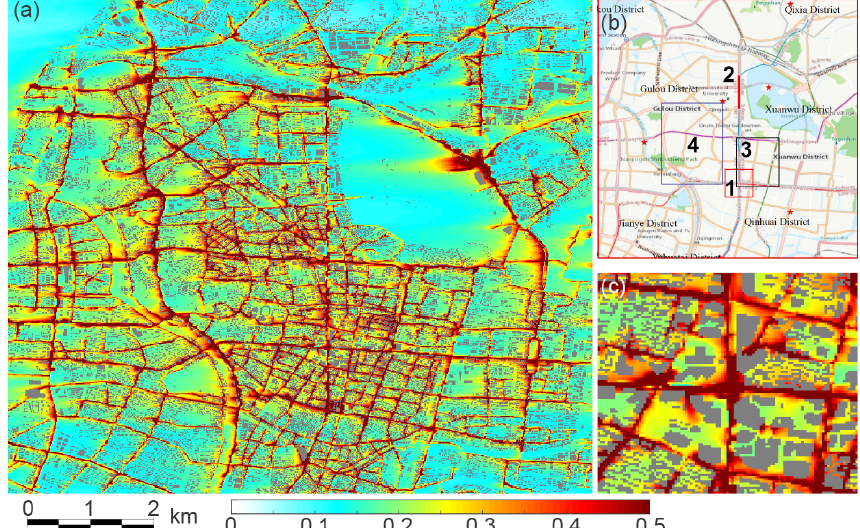
Figure 3. Modeled ground-level CO concentrations (mgm − 3 ) during rush hours by the PALM with wind from the east and speed as 6.5ms − 1 in the top of the boundary layer (a) . Panel (b) shows the corresponding city map. Panel (c) shows a close-up of the Xinjiekou area with the boundary shown as a red rectangle in panel (b) (rectangle 1). Grey areas represent tops of buildings. Map credit: ESRI 2020.